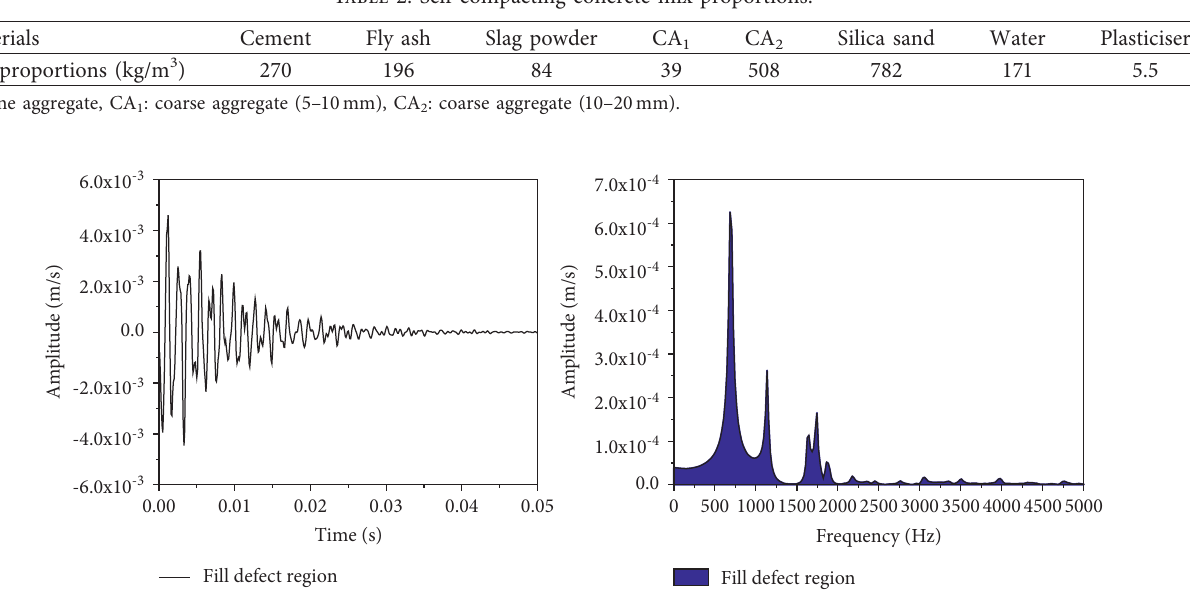
Figure 4: Time history curve and frequency spectrum of numerical simulation waveform.